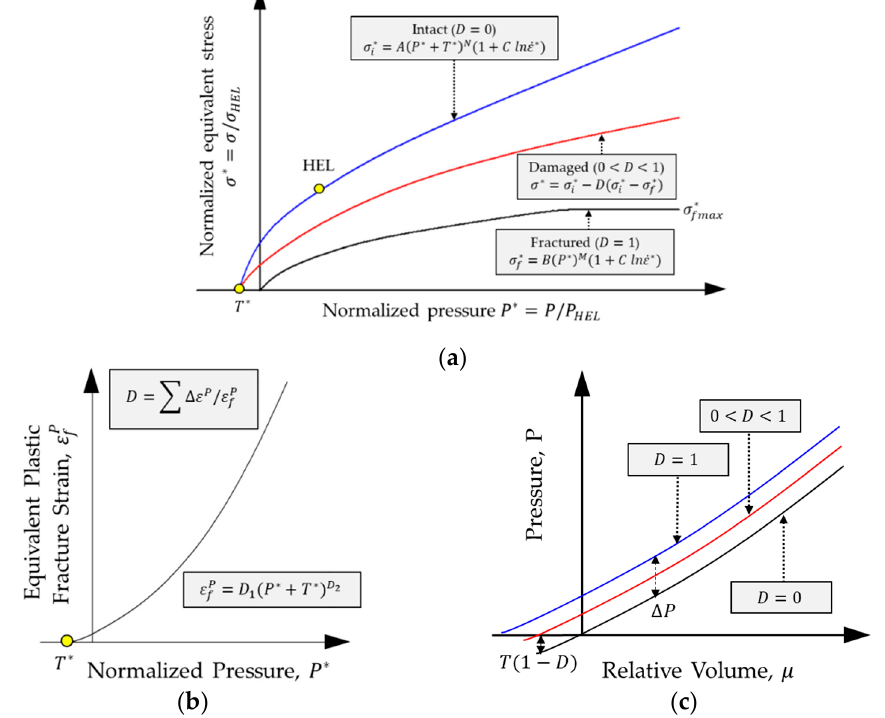
Figure 6. JH-2 material model: ( a ) strength model, ( b ) damage model, and ( c ) EOS [23].